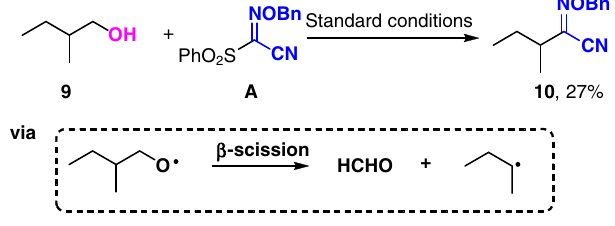
Fig. 4 The β -scission experiment. Under standard conditions,